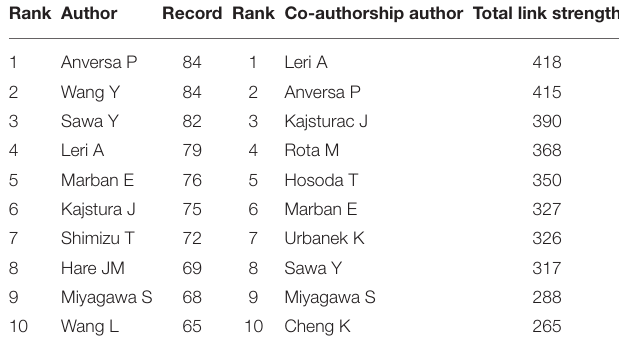
TABLE 4 | The top 10 scholars with the largest number of articles or the largest cooperation